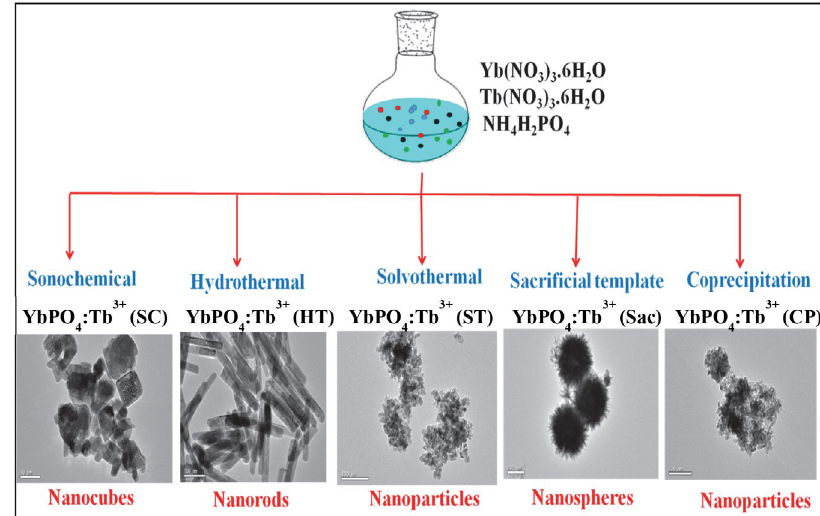
Figure 1. Overview of obtained YbPO 4 :Tb 3+